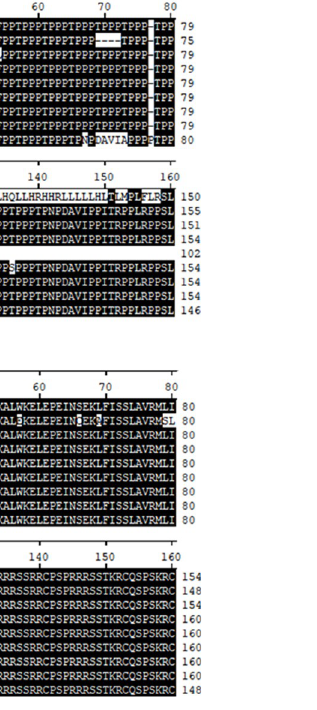
Fig 3. Sequence alignment of ORF73 and ORF20 homologs of nine PlxyGV isolates.